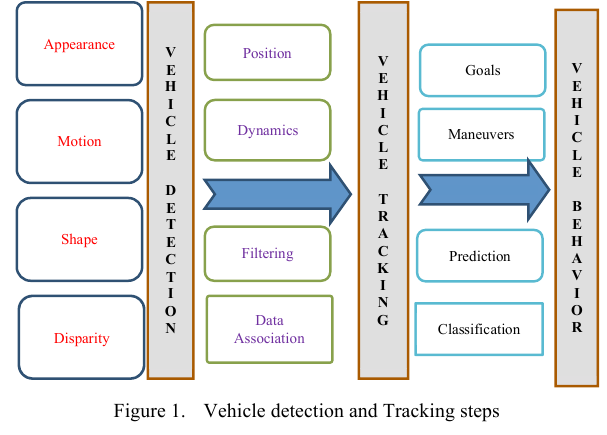
Figure 1. Vehicle detection and Tracking steps V ISION -B ASED V EHICLE D ETECTION